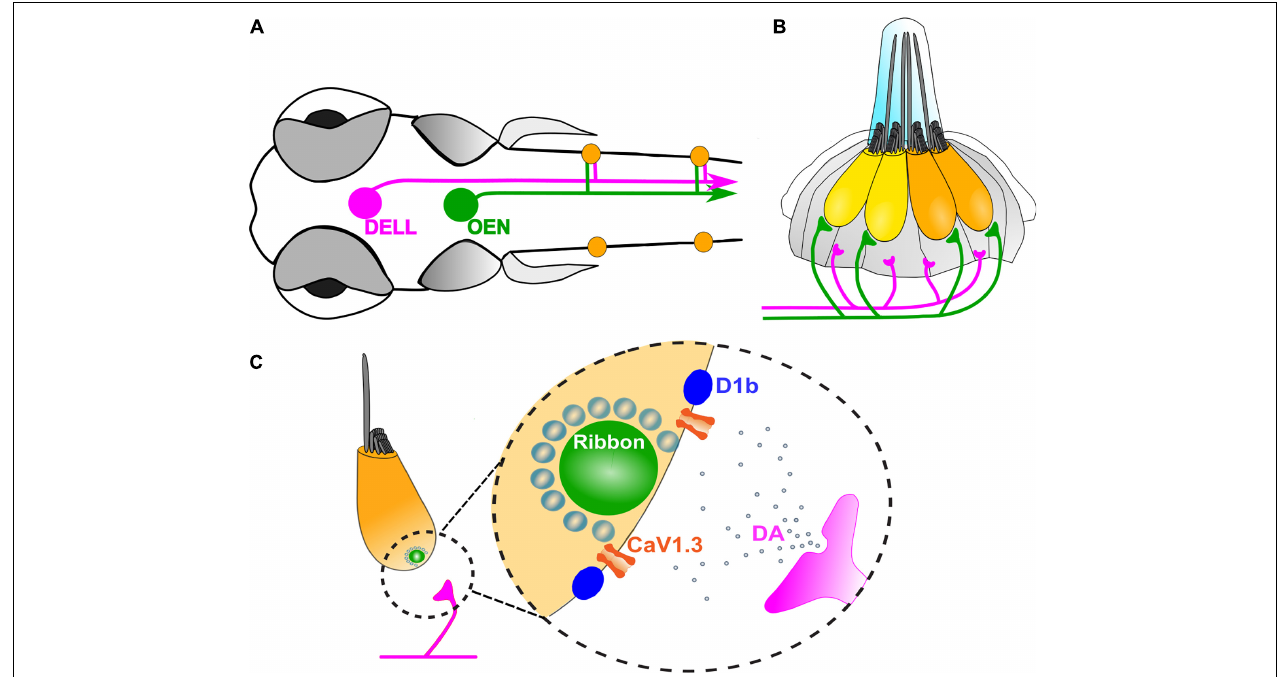
FIGURE 2 | Zebrafish efferent system. (A) Schematic representation of the head of a zebrafish larva, with the three efferent nuclei: the Diencephalic Efferent of the Lateral Line (DELL, magenta), and the Rostral and Caudal Efferent Nuclei, collectively referred to as the Octavolateral Efferent Nucleus (OEN, green). Neuromasts (orange) are innervated by descending inputs that originate from the DELL in the ventral hypothalamus (magenta) and from the OEN in the hindbrain (green) (Hashimoto et al., 1970; Russell and Roberts, 1972; Zottoli and Van Horne, 1983; Metcalfe et al., 1985; Tricas and Highstein, 1991; Bricaud et al., 2001). The circuit is midline symmetric but only one side is illustrated for clarity. (B) A side view of a single LL neuromast. One OEN fiber contacts the base of all HCs within a neuromast, independently of their polarities (Dow et al., 2018). DELL terminals are found beneath the HC layer, where supporting cells reside, but not in close apposition to HCs (Toro et al., 2015). (C) Paracrine signaling by DA is mediated by D1b receptors which are tightly localized to presynaptic zones of HCs, directly adjacent to synaptic ribbons. Activation of D1b receptors leads to an increase in the activity of presynaptic Cav1.3a channels, thus inducing a stimulatory effect on HC activity (Toro et al.,